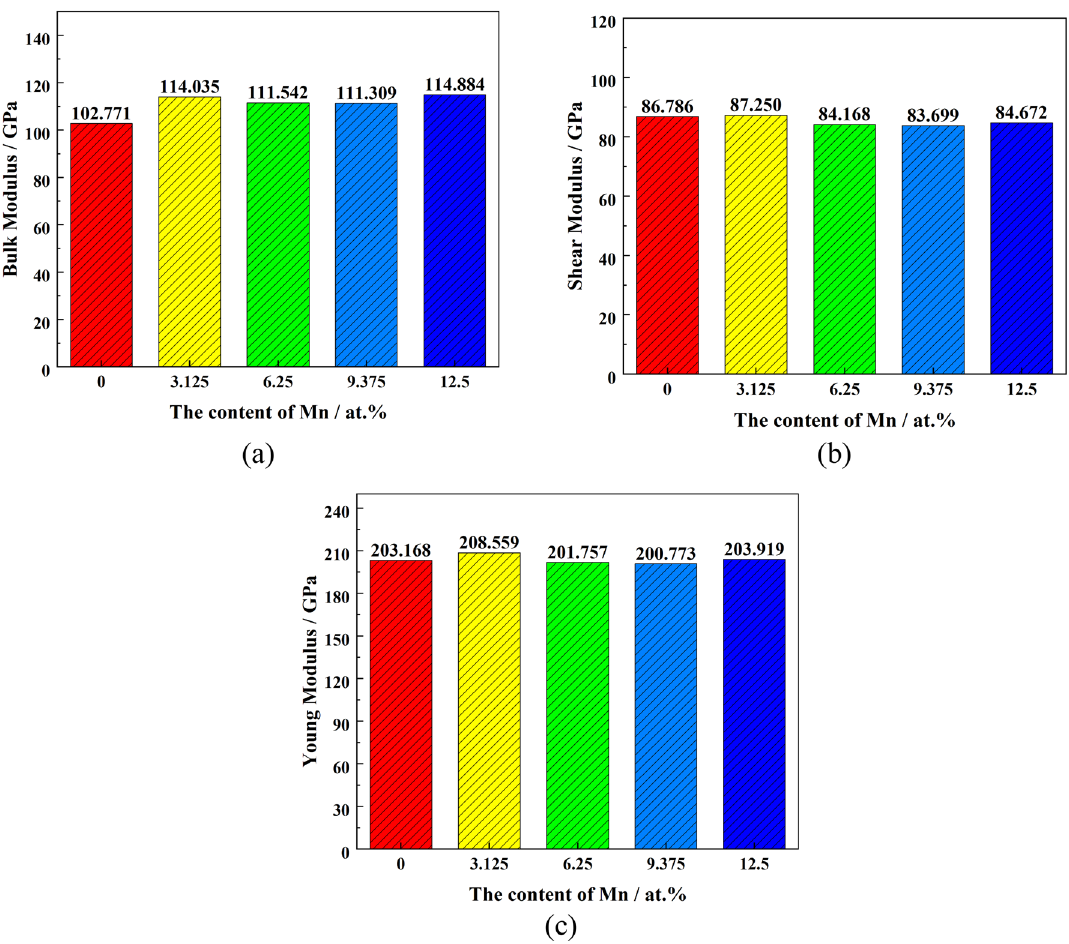
Figure 6. Elastic modulus of the five structural systems: ( a ) bulk modulus ( b ) shear modulus ( c ) Young’s